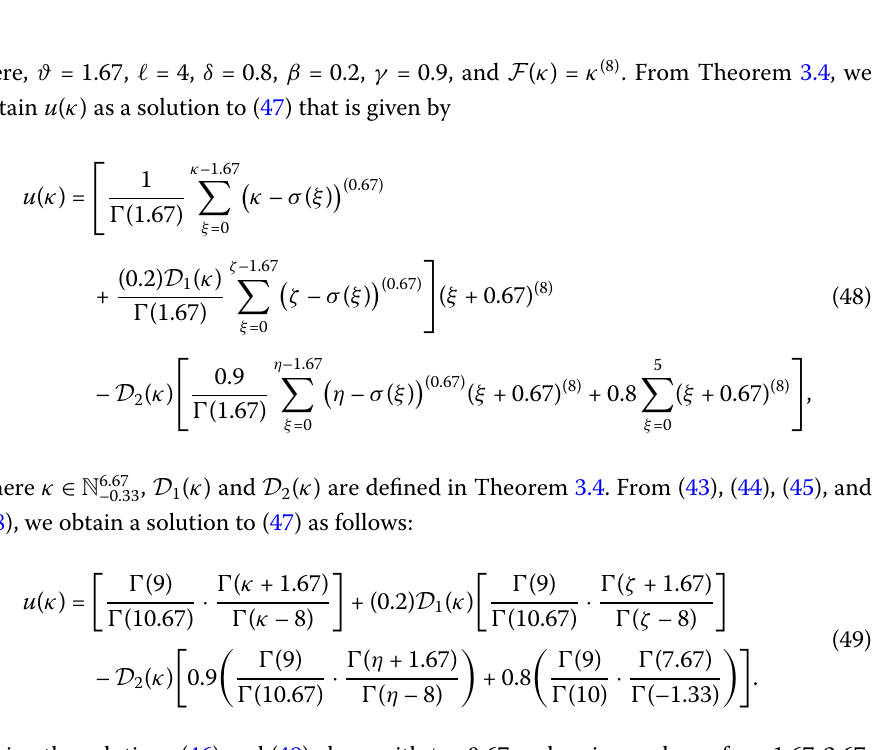
Figure 1 Solutions curves of the DFTMs (41) and (47): ( a ) κ – u plane with sensor point η ; ( b ) κ – u plane with sensor points ζ and η